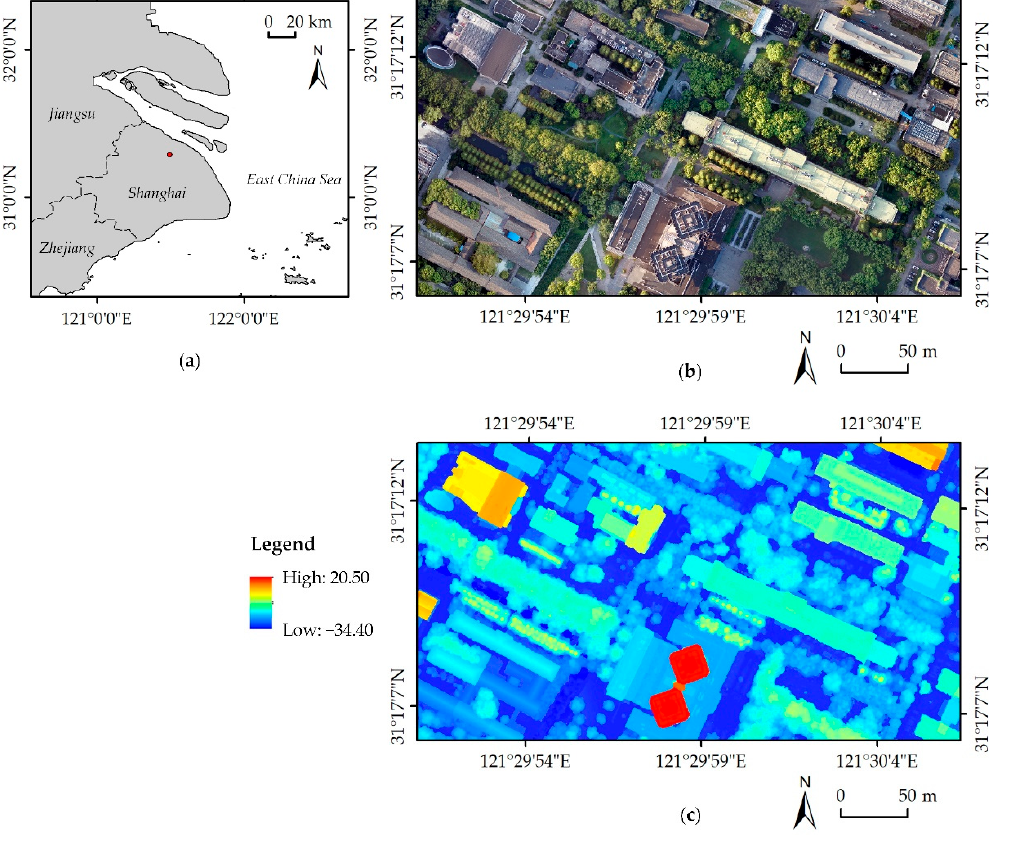
Figure 1. The location (red point) ( a ), the true color composite of Unmanned Aerial Vehicles (UAV) multispectral ortho-image ( b ), and the derived Digital Surface Model (DSM) image ( c ) of the study